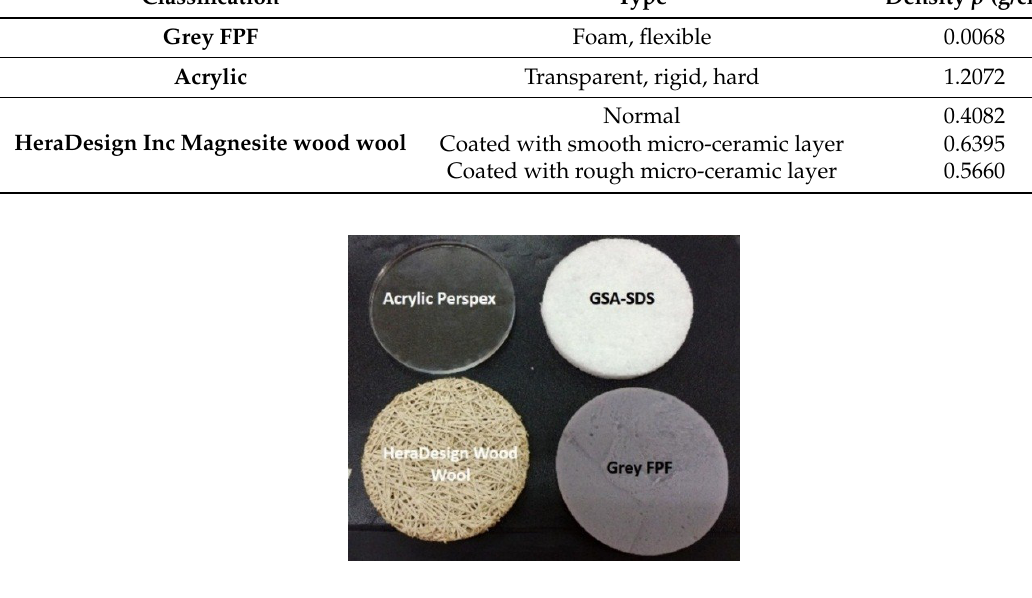
Figure 11. Various types of materials tested.